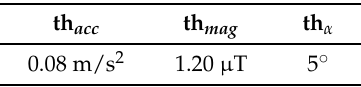
Table A1. Acceleration, magnetic field and dip angle values adopted in the vector selection performed in the threshold ‐ based approaches.